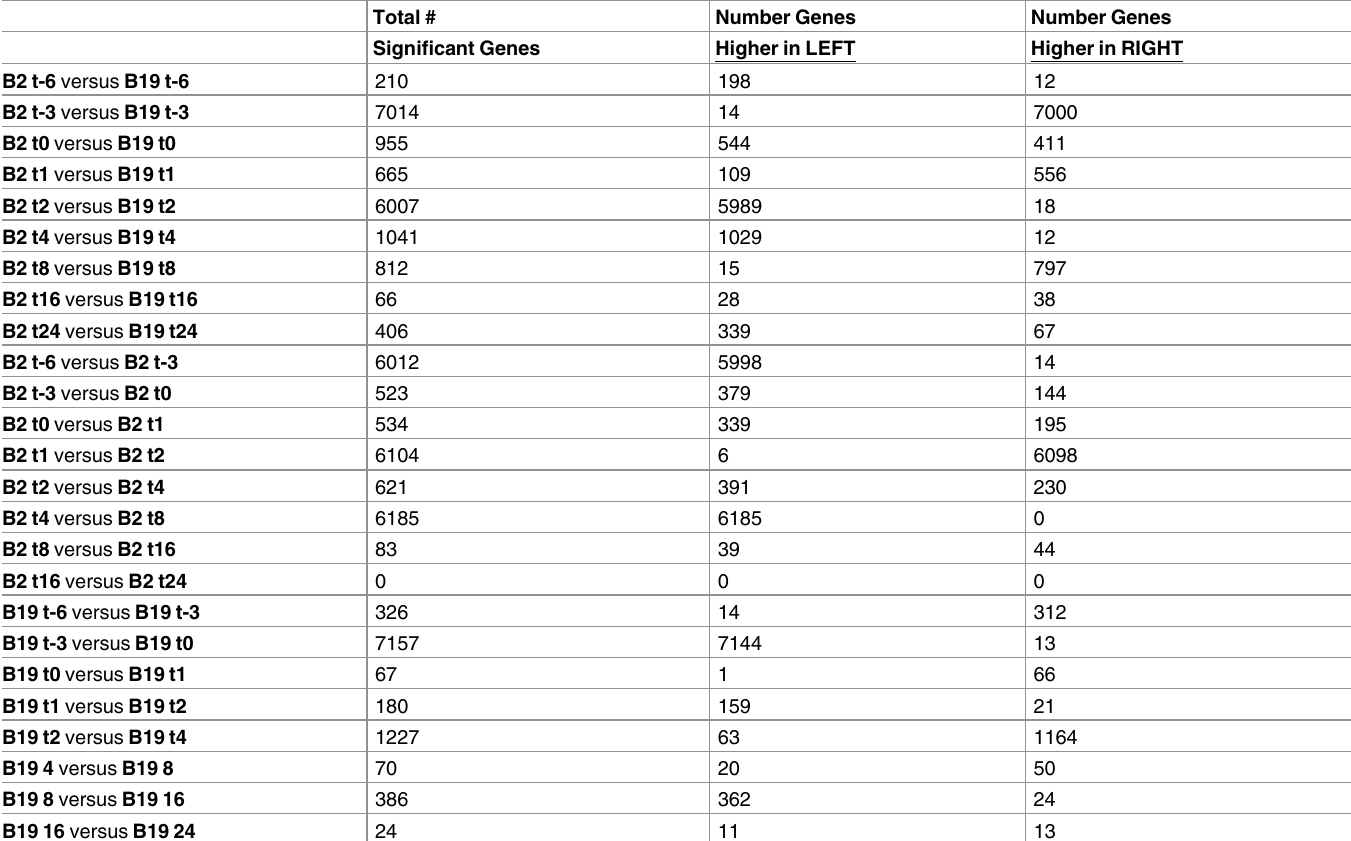
Table 2. Differencesin gene expressionbetween B2 and